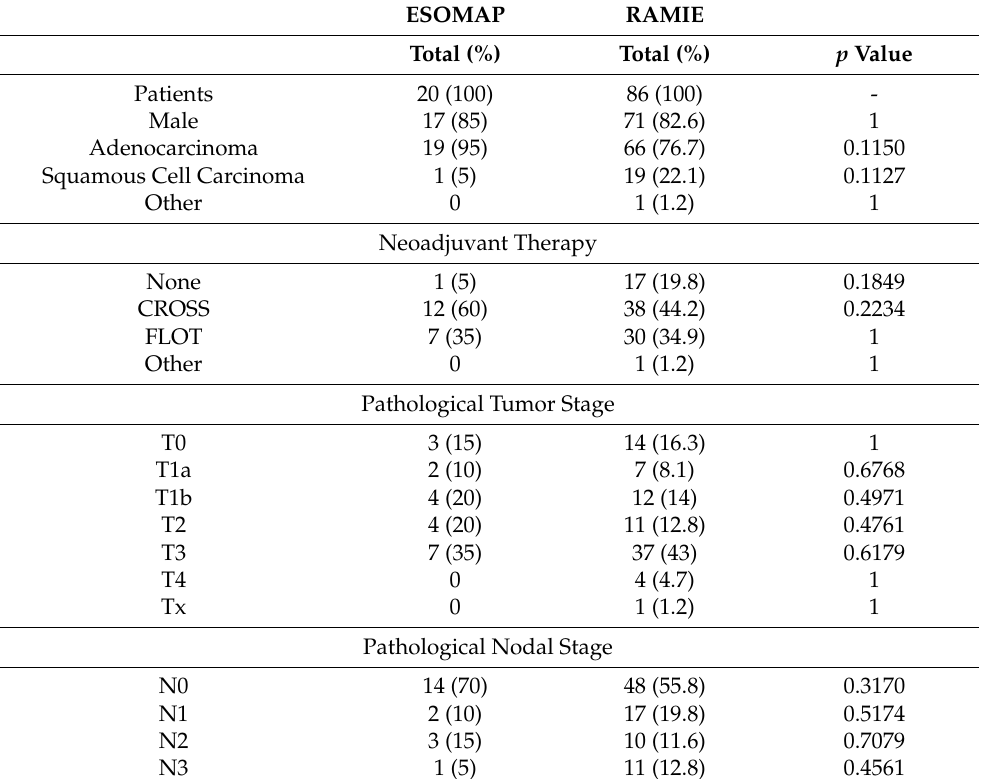
Table 1. Demographic and oncological data of patients that underwent a RAMIE procedure with and without the ESOMAP